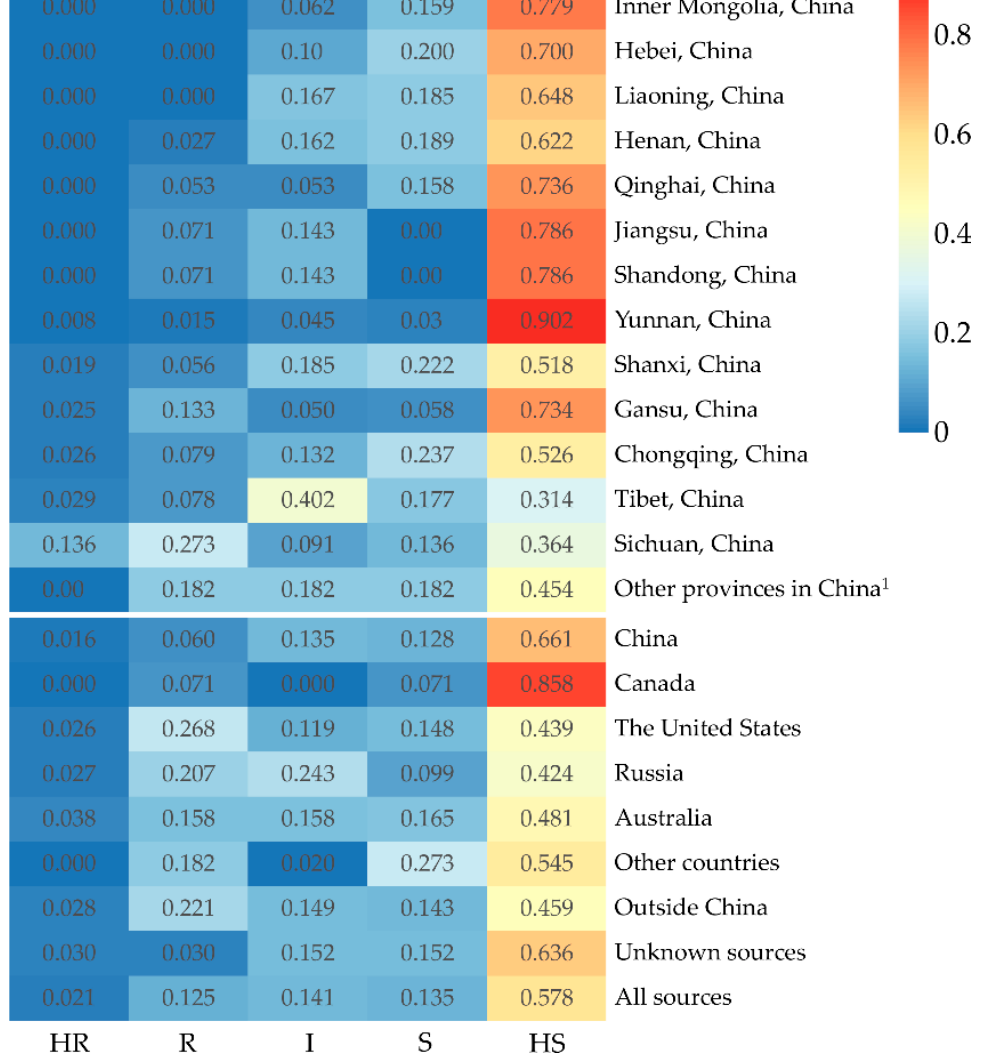
Table 4. Disease ratings of pea resistant accessions outside China and unknown sources to Fusarium oxysporum f. sp. pisi race 5.